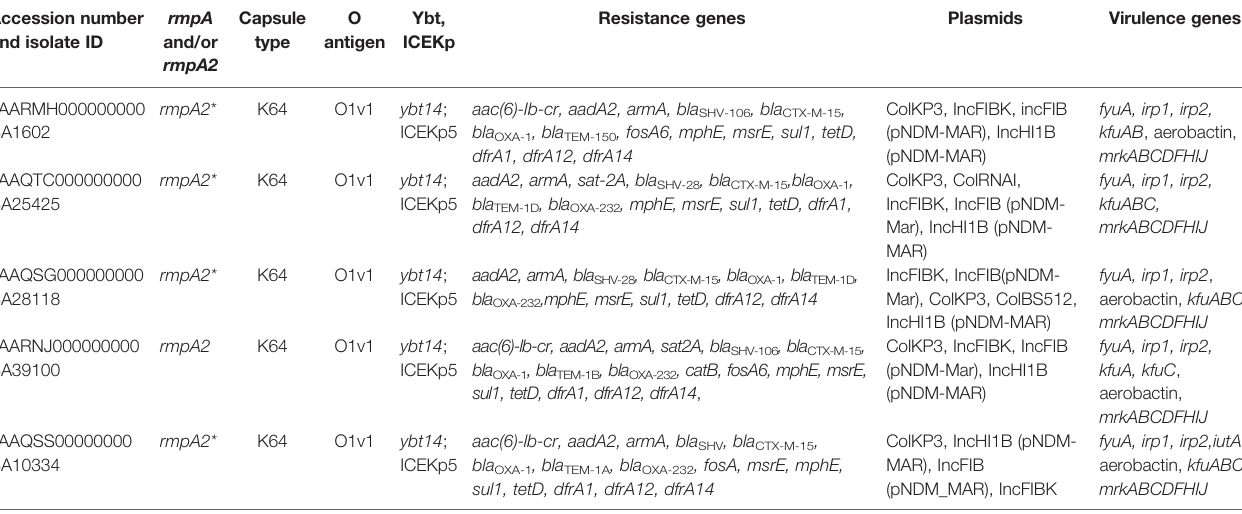
TABLE 3 | Genotypic characteristics of multidrug-resistant hypervirulent K. pneumoniae belonging to ST2096 obtained from short read